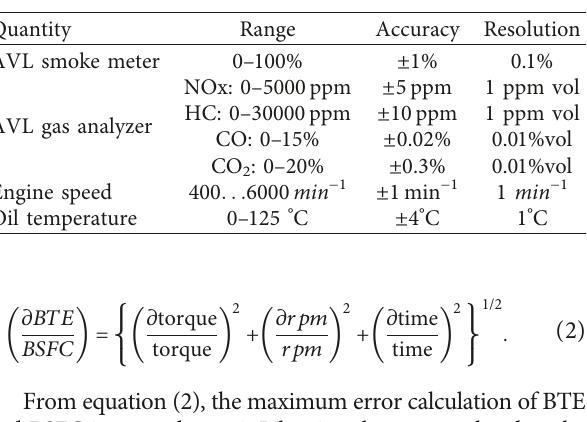
Table 4: Range, accuracy, and resolution of the